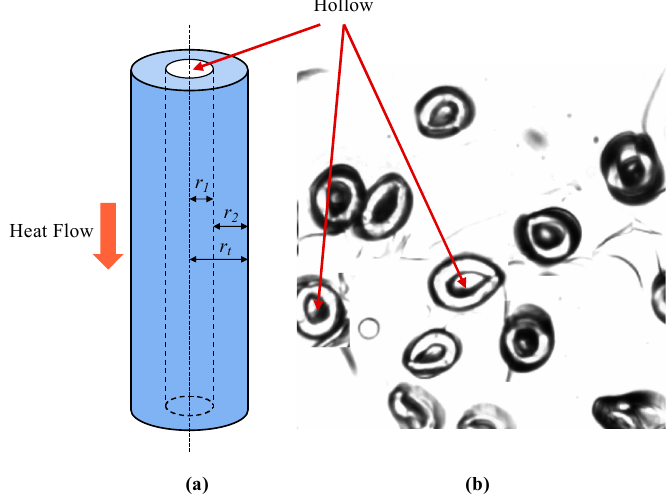
Figure 7. Heat transfer through the hollow fiber in the longitudinal ( a ) direction, and cross-sectional image of the hollow fiber ( b ).